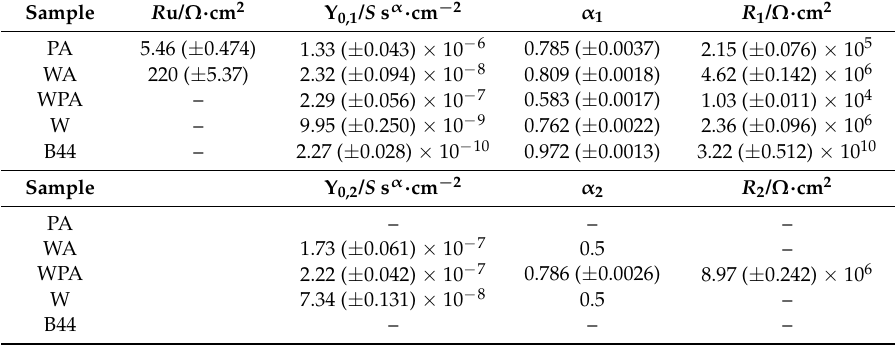
Table A1. Complete fitting parameters and error values from the equivalent circuit models in Figure A1 for each test panel. The circuit elements included are R u (uncompensated resistance), CPE 1 , R 1 , CPE 2 , and R 2 . For WA and W the Warburg element parameters are listed under CPE 2 where α 2 is fixed at 0.5 and Y 0 , 2 = 1/ σ